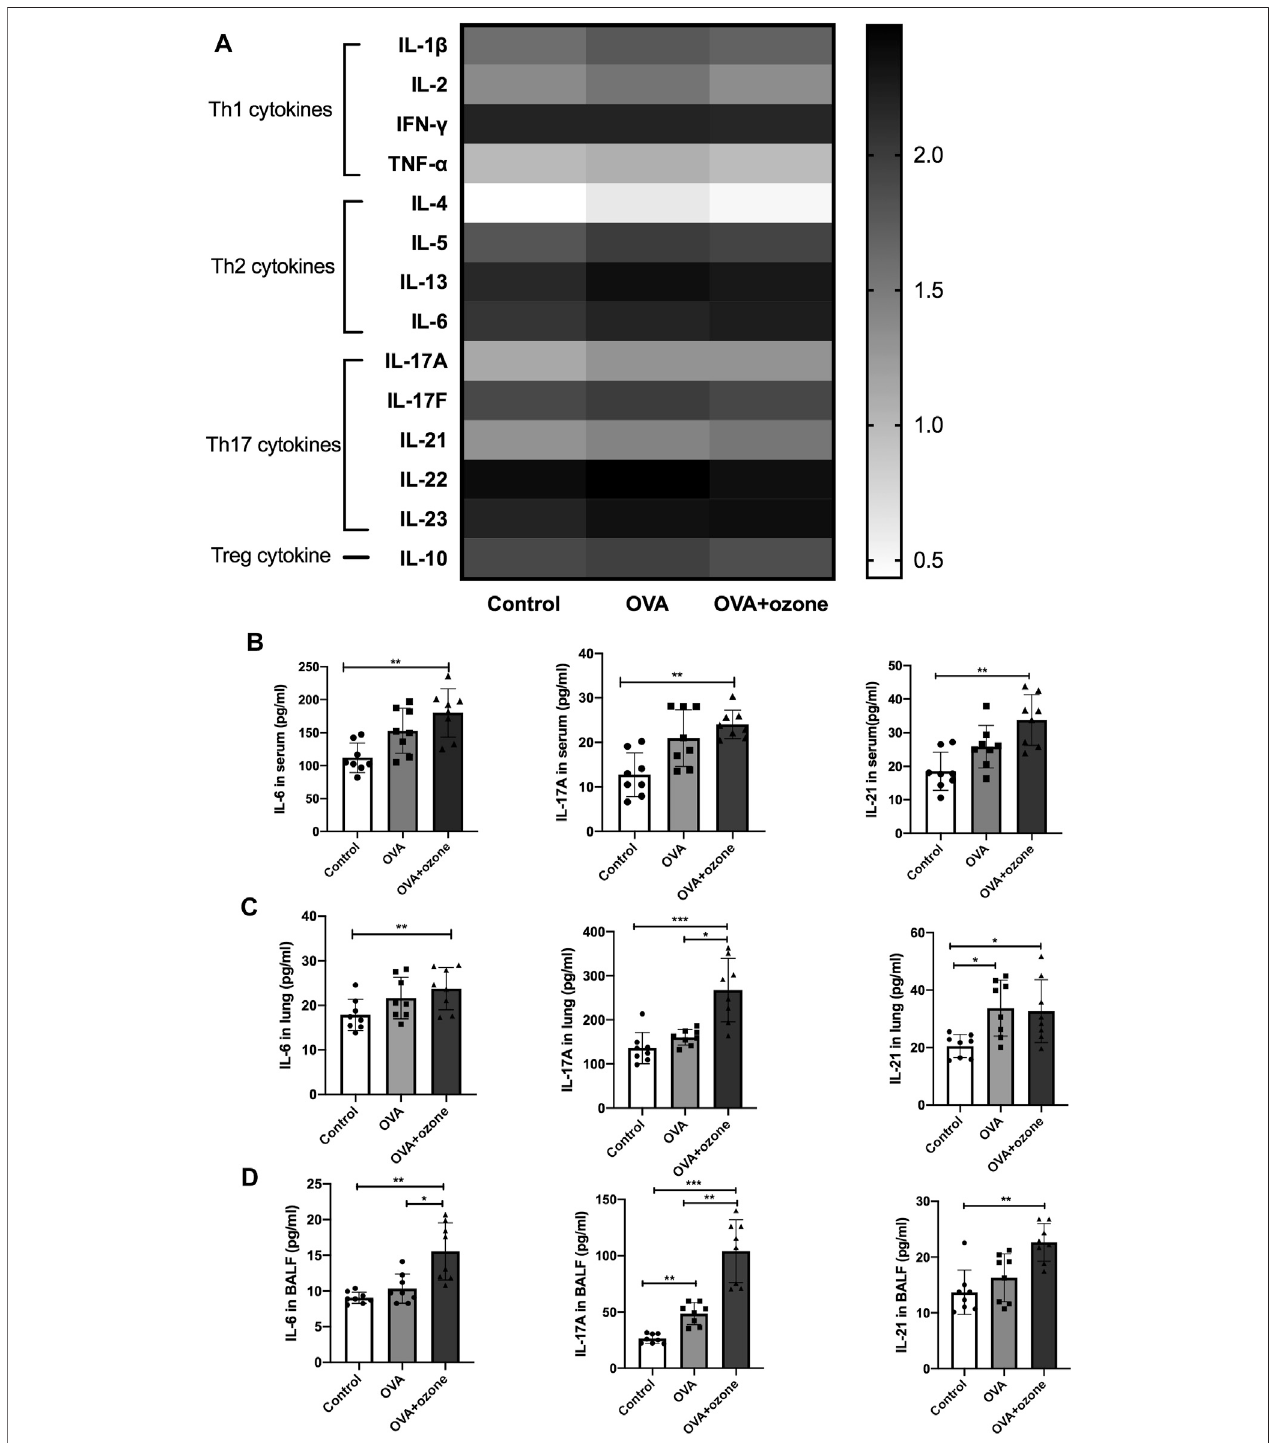
FIGURE 1 | Expression of Th1-, Th2-, and Th17-related cytokines in the serum of mice and expression of Th17-related cytokines in the lung tissue and BALF of mice.Theexpressionofcytokinesinserumwasmeasuredbycytokineantibodyarrays.TheexpressionofTh17-relatedcytokinesinBALFandlungtissuewasmeasured through ELISAs. (A) Expression of different types of cytokines in serum (statistical analysis of cytokines is shown in Supplementary Figure S1 ). (B) Expression of Th17-related cytokines in serum. (C) Expression of Th17-related cytokines in lung tissue. (D) Expression of Th17-related cytokines in BALF. To reduce the difference in expression among different cytokines, the values in panel (A) are shown in logarithmic form, whereas the original values of measured protein concentration are used for the remainder of the plates. * p < 0.05; ** p < 0.01; *** p < 0.001.